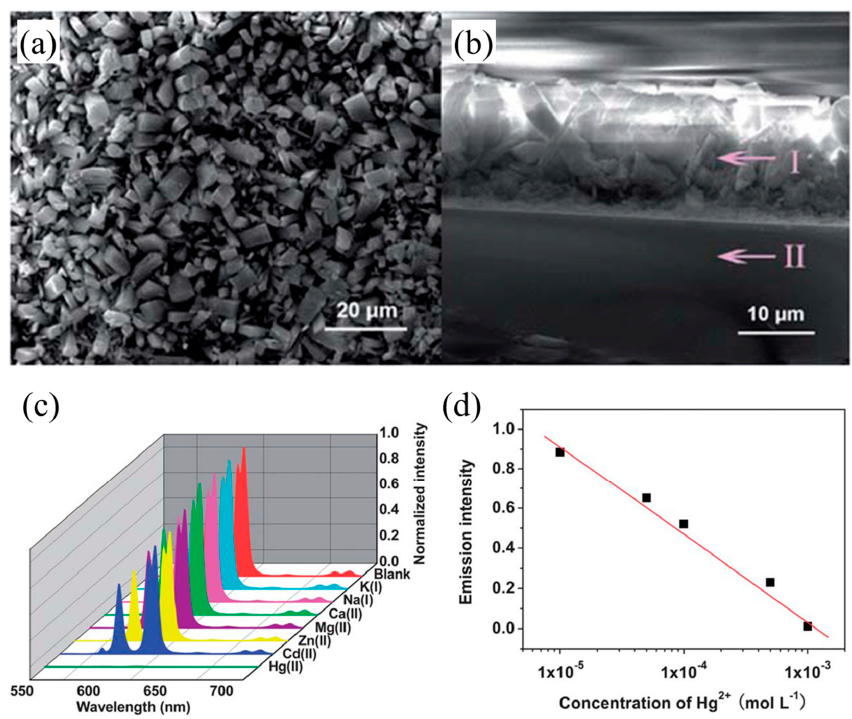
Figure 17. SEM images of a film [Eu 2 (bqdc) 3 (H 2 O)(DMF) 3 ]·0.5DMF·H 2 O: ( a ) top view and ( b ) cross-sectional view (I = [Eu 2 (bqdc) 3 (H 2 O)(DMF) 3 ]·0.5DMF·H 2 O, II = ITO glass). ( c ) Emission spectra of the film of [Eu 2 (bqdc) 3 (H 2 O)(DMF) 3 ]·0.5DMF·H 2 O after being immersed in various metal ions at 1 × 10 − 3 M. ( d ) Emission intensities of the film of [Eu 2 (bqdc) 3 (H 2 O)(DMF) 3 ]·0.5DMF·H 2 O immersed in Hg 2+ at various concentrations. Reprinted with permission from Reference